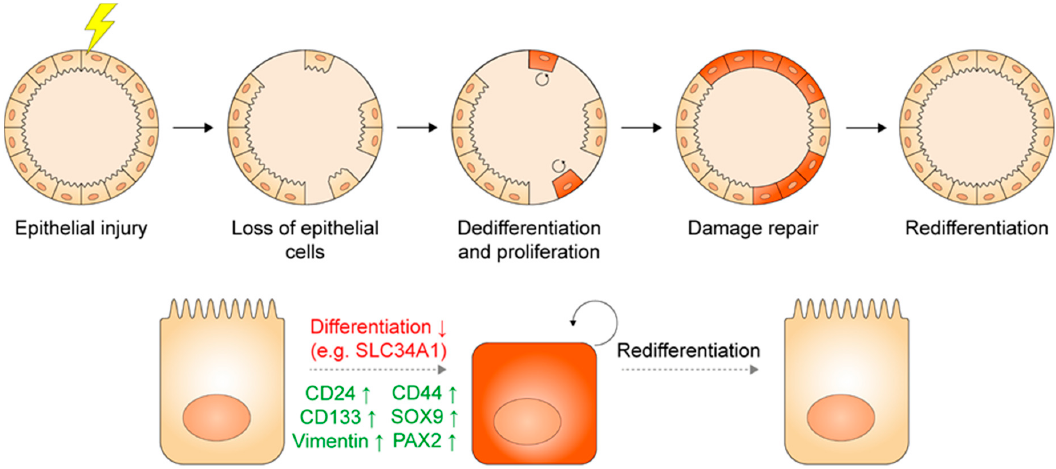
Figure 3. Proposed mechanism for regeneration in the adult proximal tubule. Upon injury, generic di ff erentiated epithelial cells dedi ff erentiate, proliferate and redi ff erentiate to repair the damage. During this process, di ff erentiated cells lose markers of di ff erentiation (e.g., the brush border, specific transporters) and upregulate markers that indicate a stem or progenitor cell state (CD24, CD133, Vimentin and probably CD44, SOX9 and PAX2 as well).